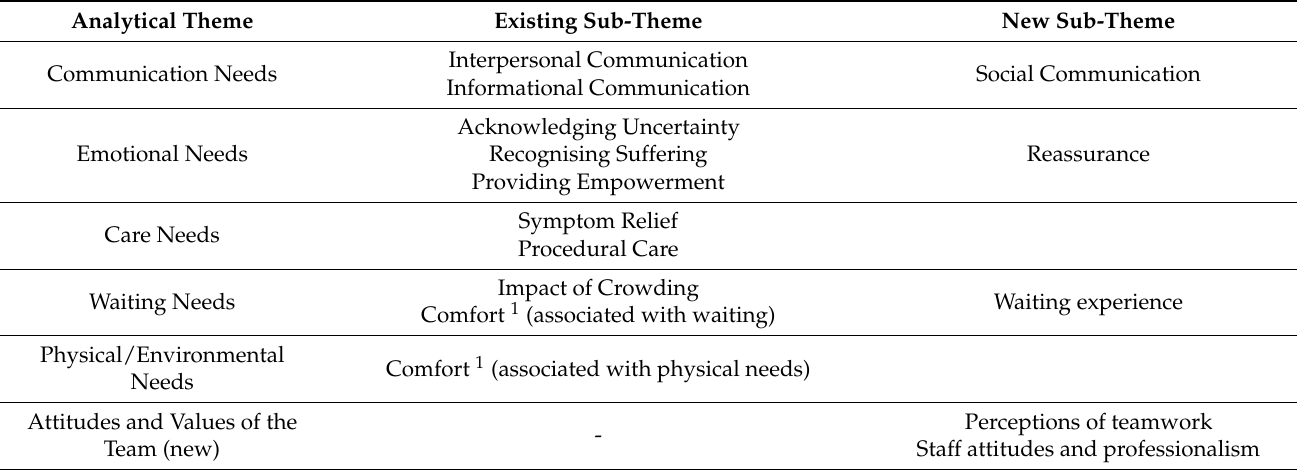
Table 5. Analytical Themes and